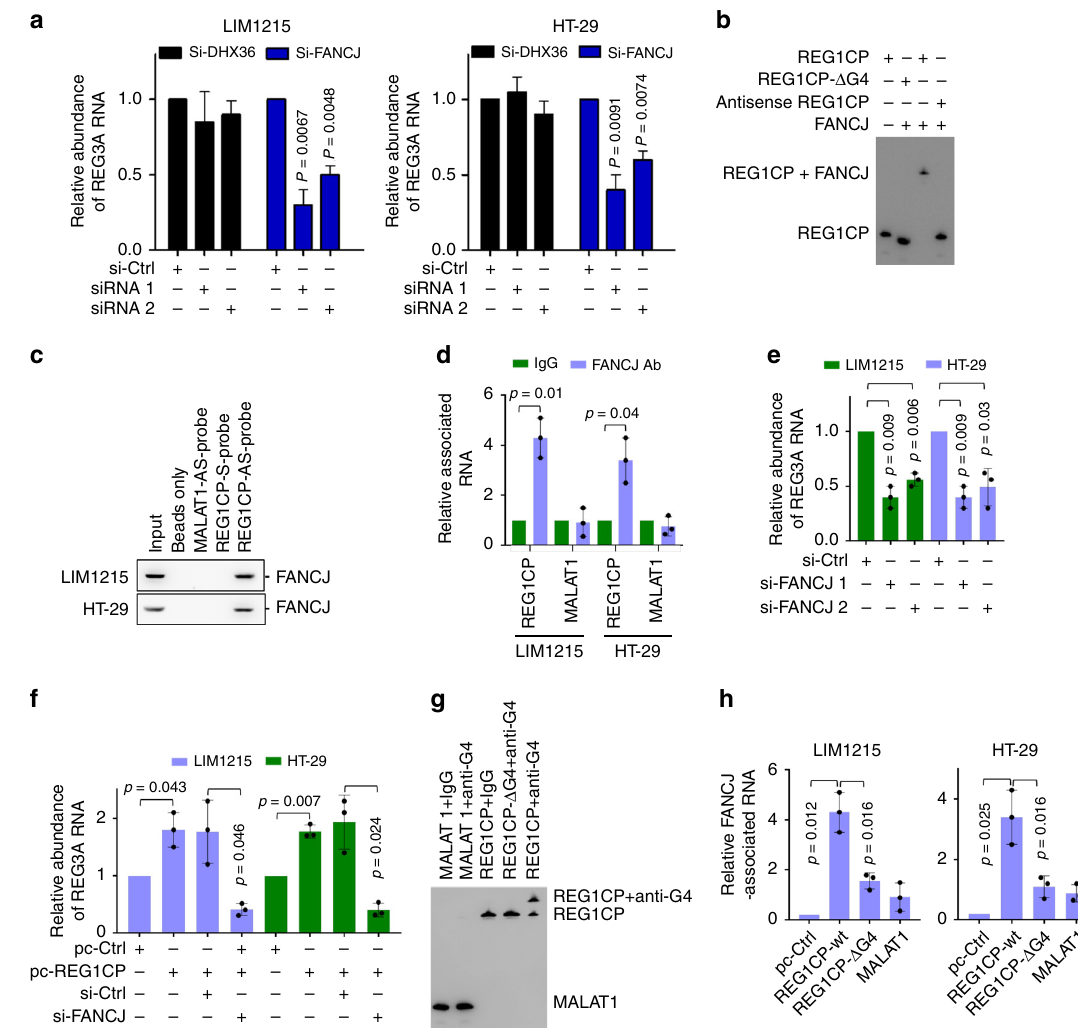
Fig. 5 REG1CP binds to FANCJ. a Silencing of FANCJ but not DHX36 inhibited REG3A mRNA expression. b FANCJ bound to wild-type REG1CP but not a REG1CP mutant with the G-quadruplex deleted (REG1CP- Δ G4). In vitro-synthesized biotin-labelled REG1CP sense RNA (REG1CP) or antisense RNA (Antisense REG1CP) or REG1CP- Δ G4 was incubated with the immunoprecipitated FANCJ from nuclear extracts of LIM1215 cells followed by EMSA. c Binding of FANCJ to REG1CP was detected using RNA pulldown assays. Proteins co-pulled down with biotin-labelled REG1CP sense probe (REG1CP-S- probe) or REG1CP antisense probe (REG1CP-AS-probe) were analysed using western blotting. d Binding of FANCJ to REG1CP was detected using RNA immunoprecipitation (RIP) assays. RNAs co-precipitated with an antibody against FANJ from nuclear extracts of LIM1215 and HT-29 cells were analysed using qPCR. e FANCJ silencing reduced REG3A mRNA levels. Relative REG3A mRNA abundance was quantitated using qPCR in LIM1215 and HT-29 cells introduced with the control or FANCJ siRNAs. f FANCJ silencing diminished upregulation of REG3A by overexpression of REG1CP. Relative REG3A mRNA abundance was quantitated using qPCR in LIM1215 and HT-29 cells introduced with the control or FANCJ siRNAs with or without overexpressing REC1CP. g An anti-G-quadruplex antibody bound to wild-type REG1CP but not a REG1CP mutant with the G-quadruplex deleted (REG1CP- Δ G4). In vitro-synthesized biotin-labelled REG1CP or REG1CP- Δ G4 were incubated with the isotype control (rabbit IgG) or an anti-FANCJ antibody followed by analysis using EMSA. In vitro-synthesized biotin-labelled MALAT1 was included as a control. h FANCJ bound to wild-type REG1CP but not REG1CP- Δ G4. LIM1215 and HT-29 cells with endogenous REG1CP stably silenced were introduced with exogenous REG1CP or REG1CP- Δ G4. FANCJ-associated REG1CP was detected using RIP assays. n = 3 independent experiments. Data are presented as Mean ± SEM ( a , d , e , f , h ) or representatives ( b , c , g ). Statistical signi fi cance was calculated using a two-tailed t